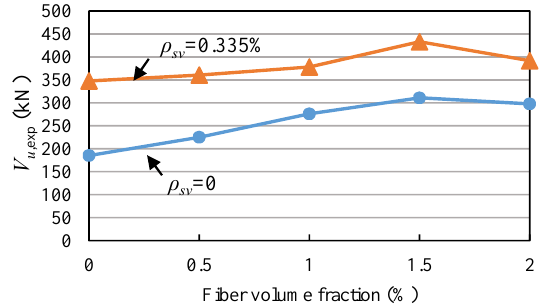
Figure 10. Relationship of shear capacity and fiber volume fraction.